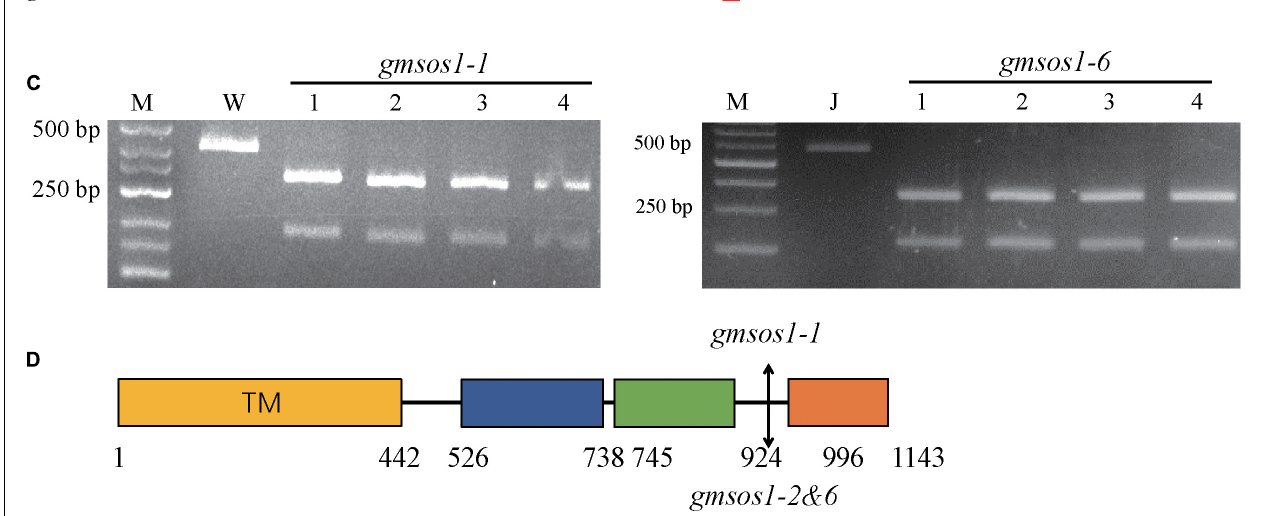
Frontiers in Plant Science |